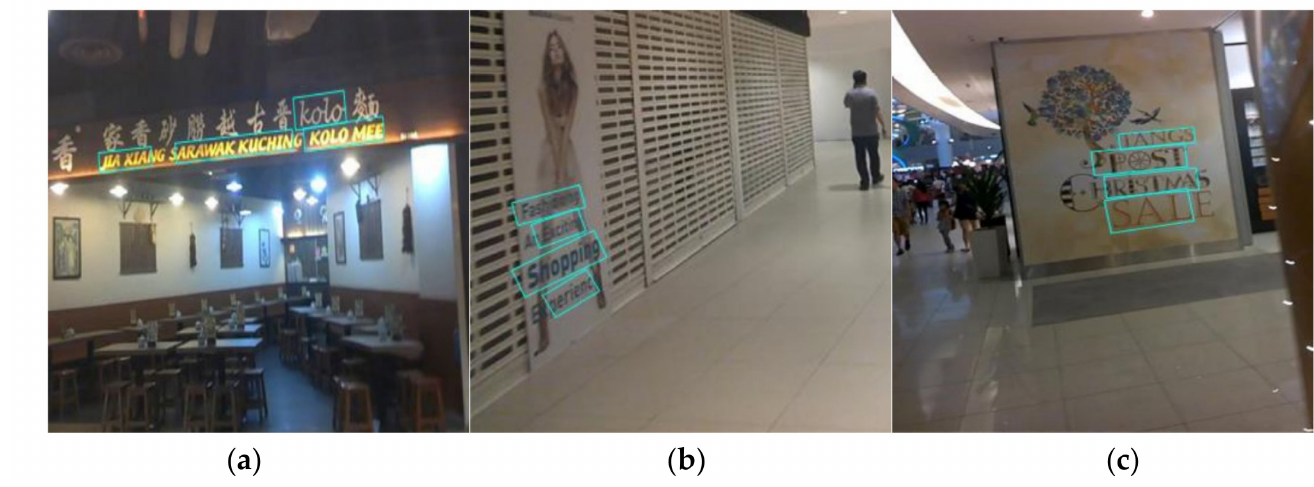
Figure 15. Text detection results of EAST algorithm: ( a ) test image 1, ( b ) test image 2, and ( c ) test image 3.